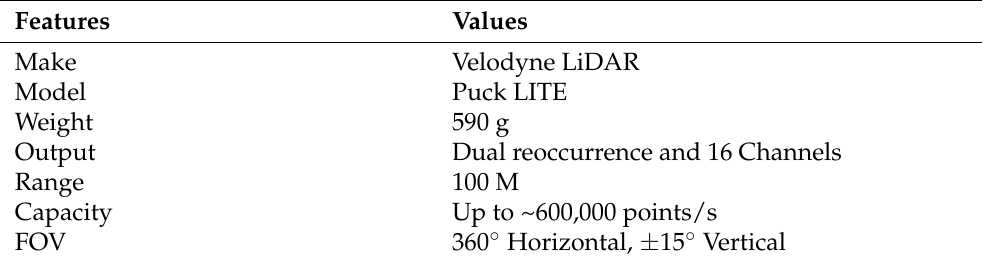
Table 2. LiDAR Configuration.